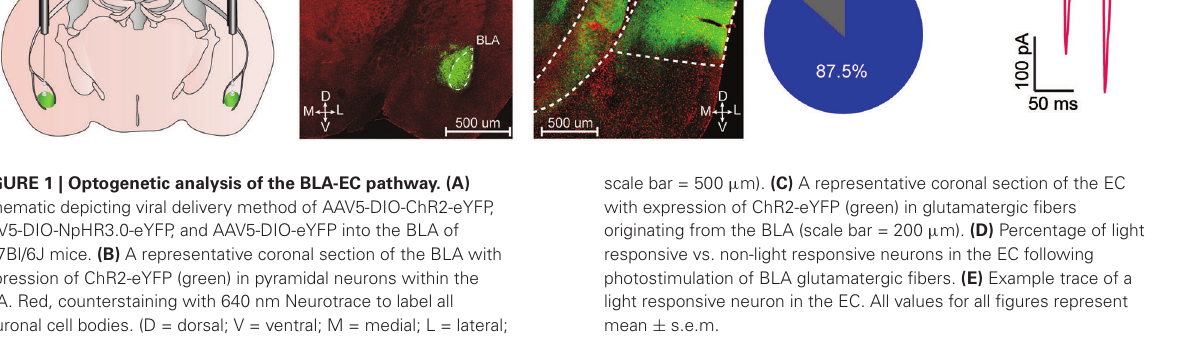
FIGURE 1 | Optogenetic analysis of the BLA-EC pathway. (A) Schematic depicting viral delivery method of AAV5-DIO-ChR2-eYFP, AAV5-DIO-NpHR3.0-eYFP, and AAV5-DIO-eYFP into the BLA of C57Bl/6J mice. (B) A representative coronal section of the BLA with expression of ChR2-eYFP (green) in pyramidal neurons within the BLA. Red, counterstaining with 640 nm Neurotrace to label all neuronal cell bodies. (D = dorsal; V = ventral; M = medial; L = lateral;